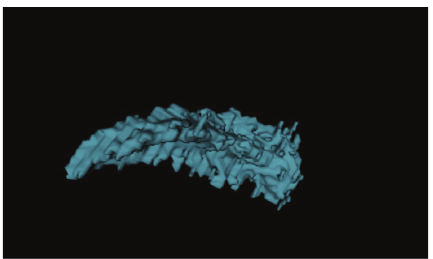
Figure 2: Three-dimensional reconstructed MDCT image shows posterolateral view of right adrenal